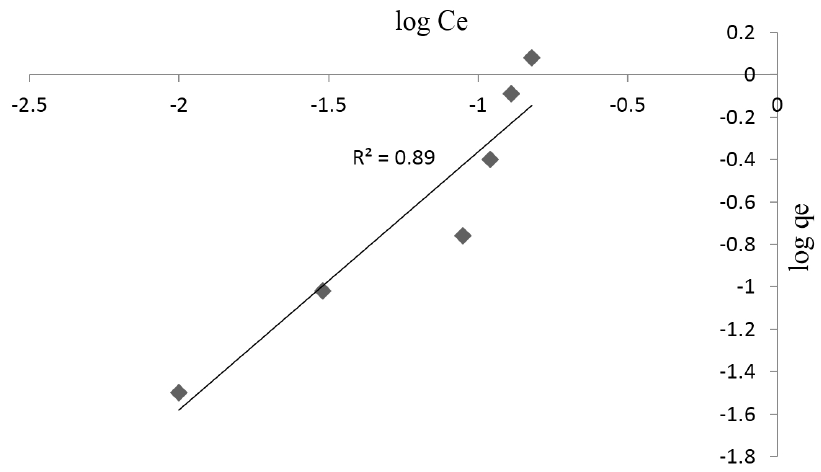
Figure 8. Freundlich plot for Pb 2+ adsorption onto synthesized chitosan.